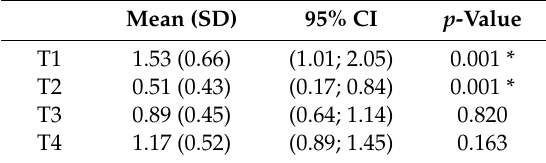
Table 1. Linear increase in buccal soft tissue profile (BSP) at the di ff erent time points.